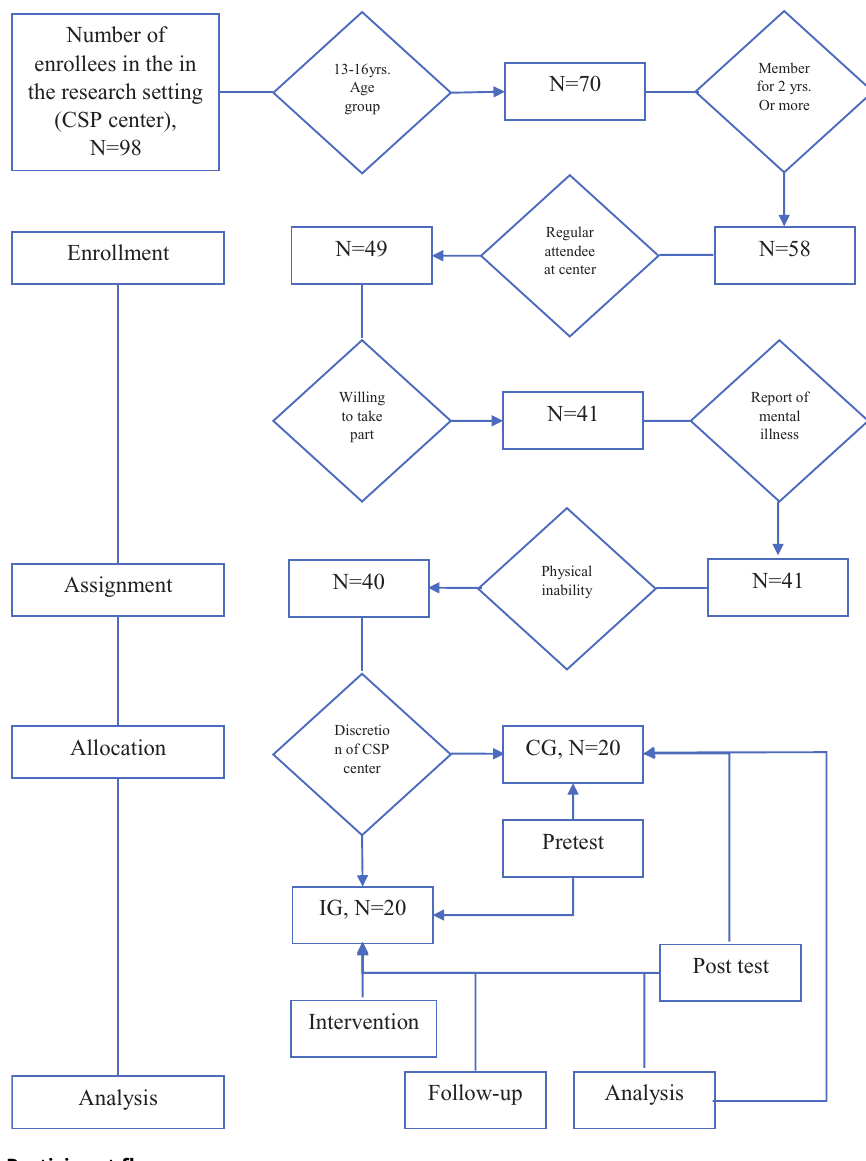
Figure 2. Participant